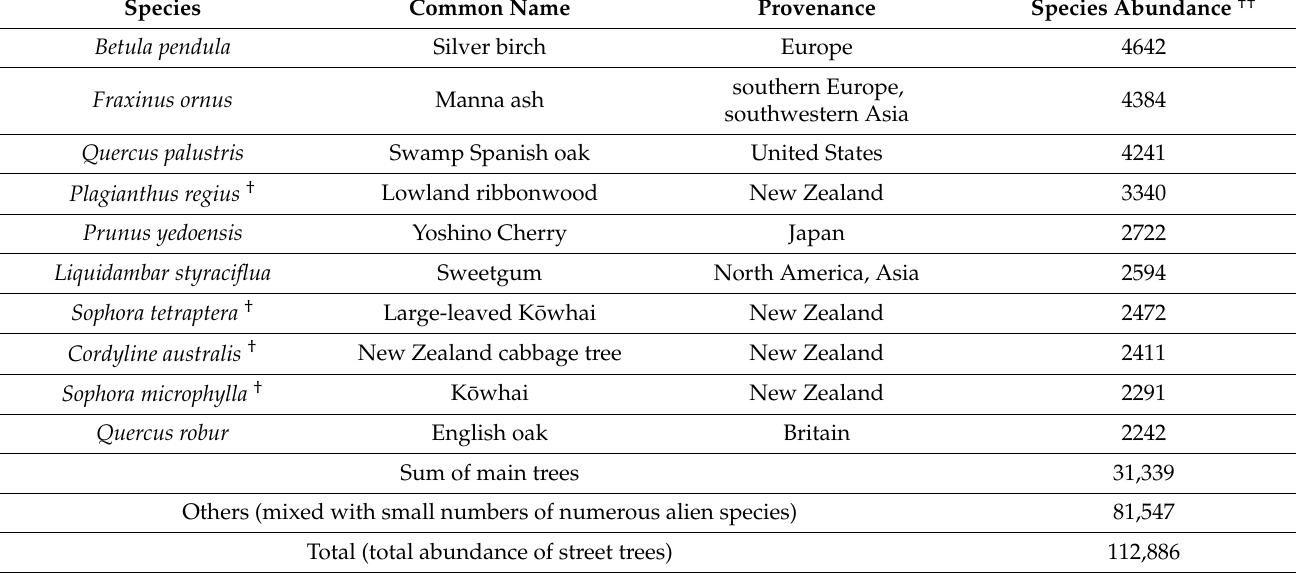
Table 1. List of the main street trees of Christchurch and planting status in 2020